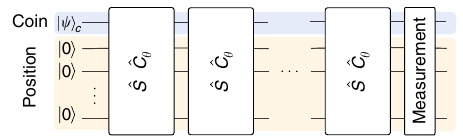
Fig. 1 Discrete-time quantum walk scheme. Each step is composed of a quantum coin operation, ^ C θ , with tunable effective coin bias parameters, θ i , followed by a shift operation, ^ S